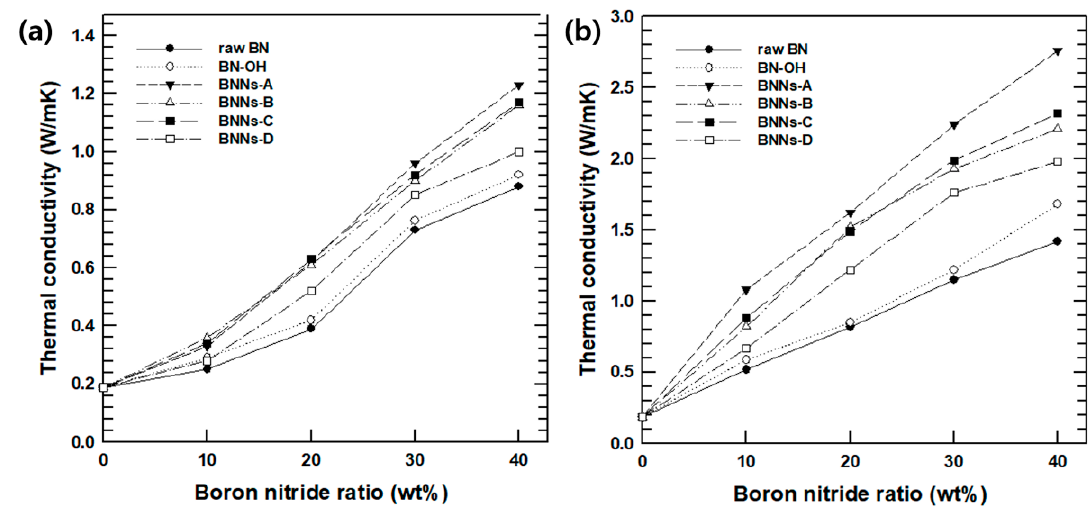
Figure 7. Thermal conductivity from LFA data of raw PPA, raw BN / PPA, BN–OH / PPA BNNs–X / PPA, through plane( a ), and in-plane ( b ).